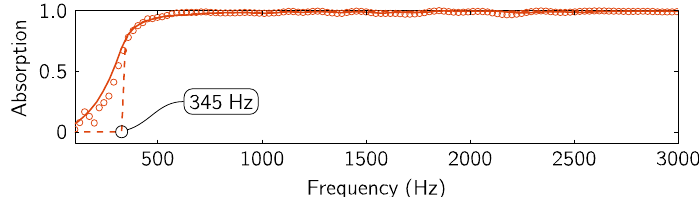
Figure 4. Absorption performance of the metamaterial unit with a thin layer of acoustic sponge placed on top. Red circles are the data points measured by the impedance tube, and the red solid line is the calculated absorption by using the impedance evaluated from Equation (15). Here, the value of b used in the calculation is 1420 Hz, and = 1.4. The dashed line indicates the designed cutoff frequency. Excellent agreement between theory and experiment is seen. The absorption below the cutoff frequency is largely due to the acoustic sponge.